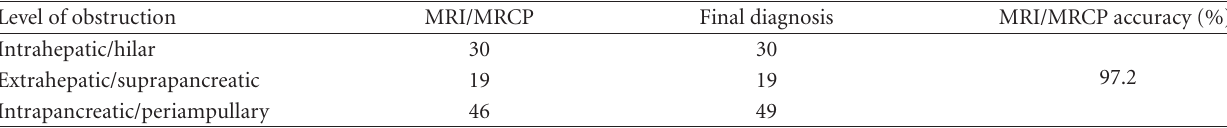
Table 1: The distribution of 98 di ff erent levels of the biliary tract obstruction ( n : 91).